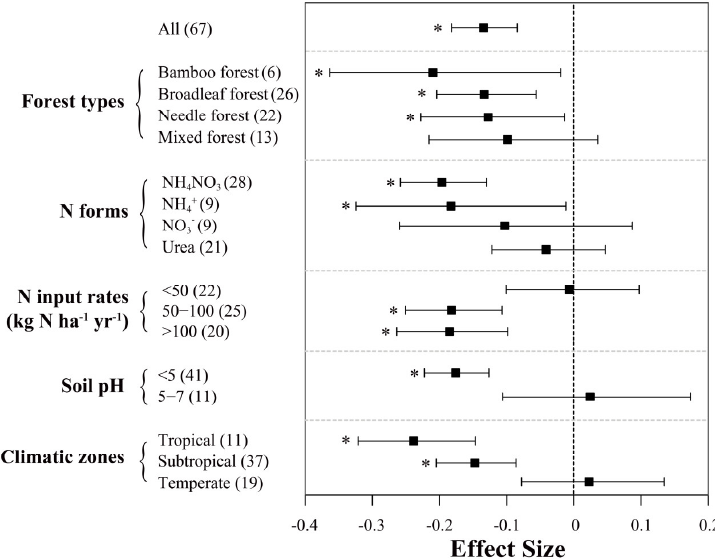
Figure 4. Effects of N inputs on forest soil CH 4 uptake in China. Error bars represent 95% confidence